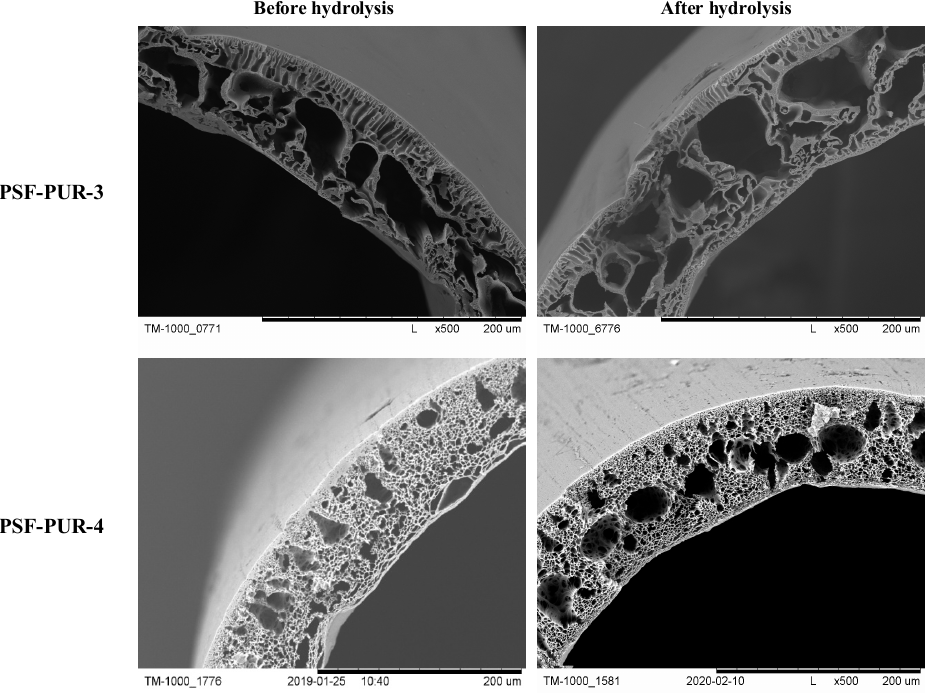
Figure 7. The crosssection and part of the crosssection of the PSF-PUR-3 and PSF-PUR-4 membranes before and after hydrolysis.